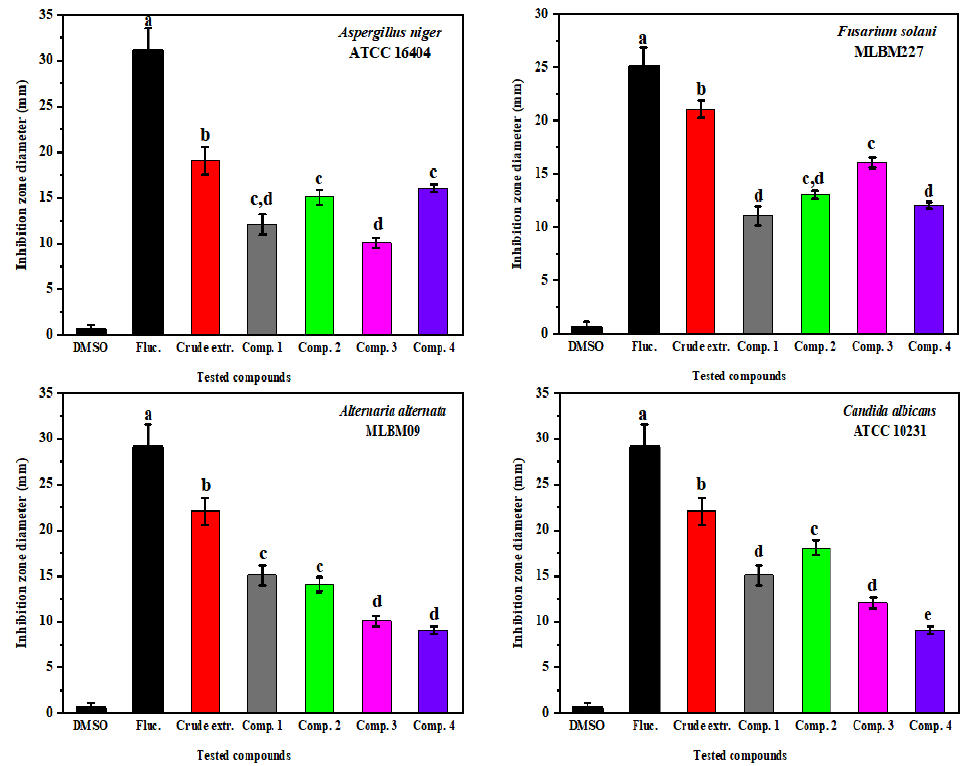
Figure 8. Antifungal activity of pure compounds and the crude extract against tested fungal pathogens. Error bars represent standard error of the means ( n = 3).